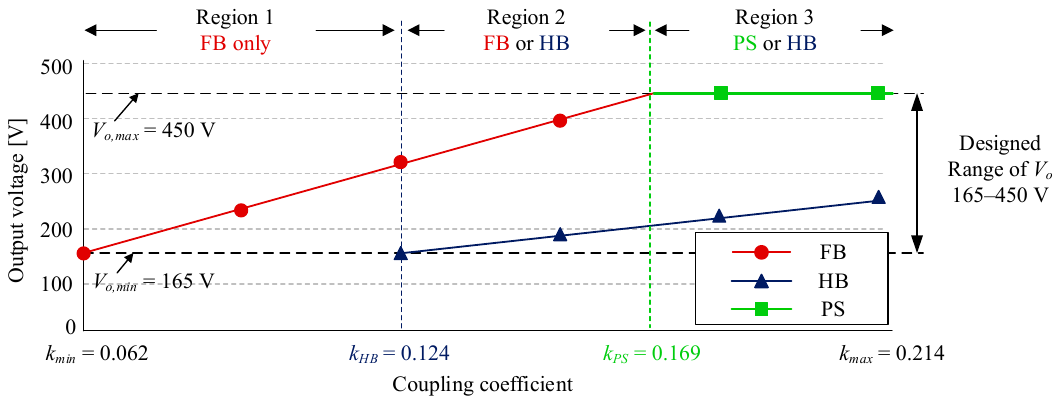
Figure 3. Output voltage analysis and applicable control modes with respect to the coupling coefficient.